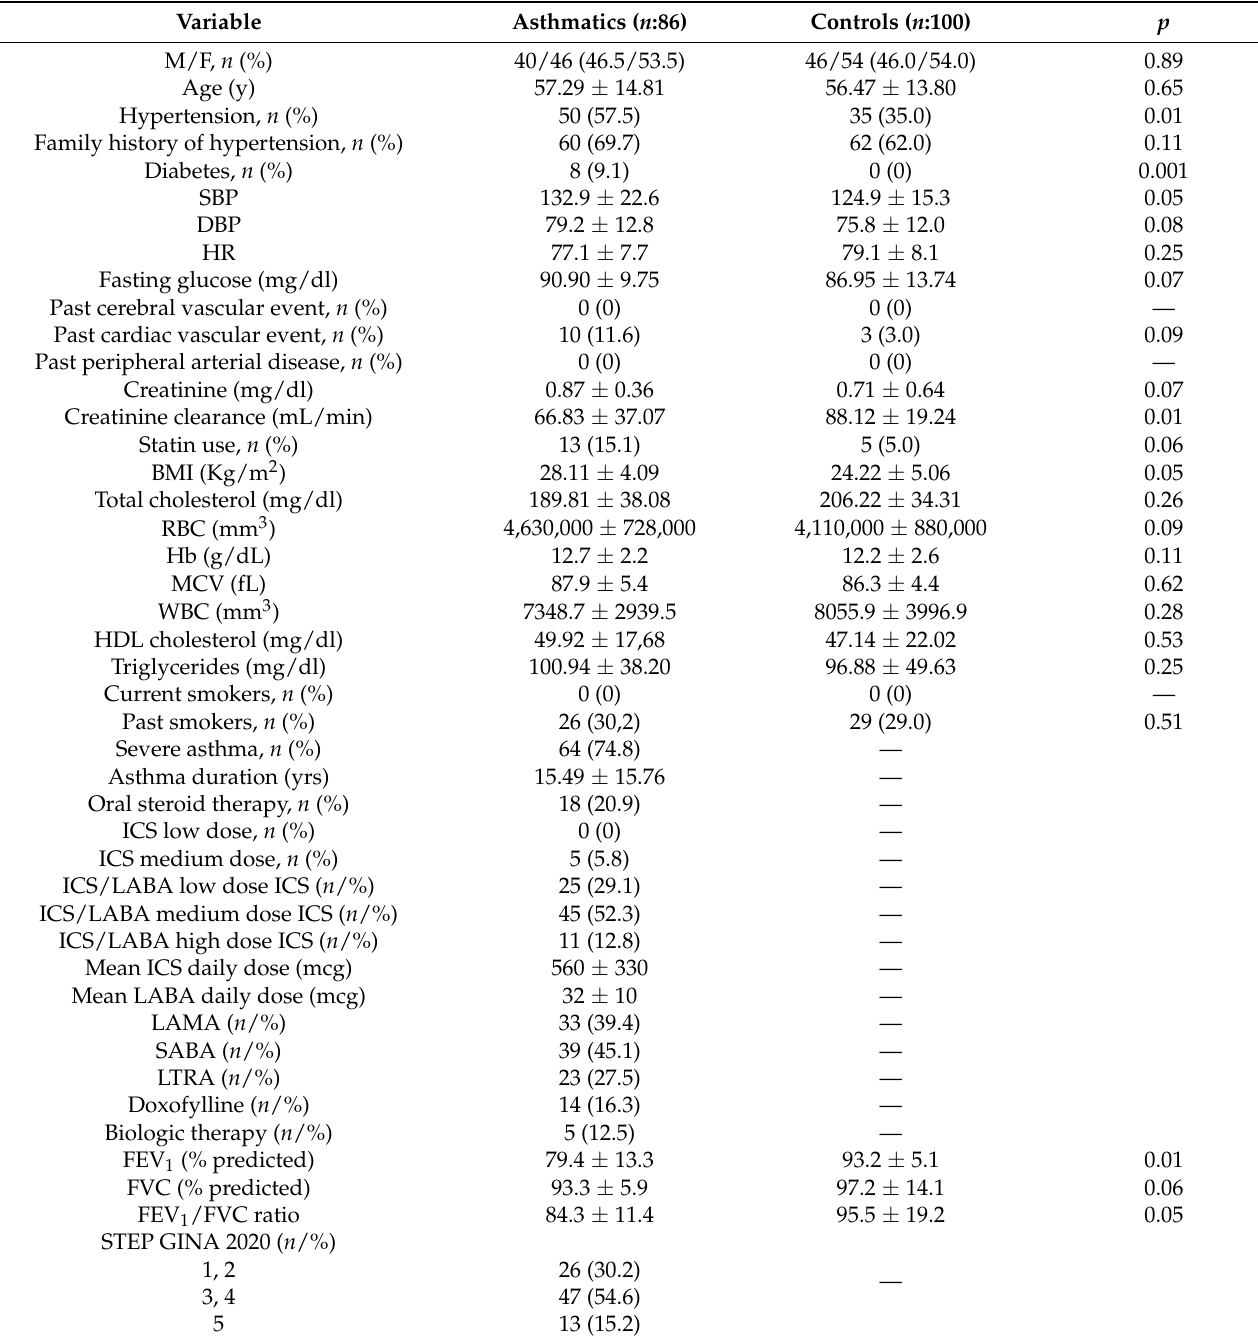
Table 1. Anthropometric, clinical, and laboratory variables: asthmatics vs. controls. Variable Asthmatics ( n